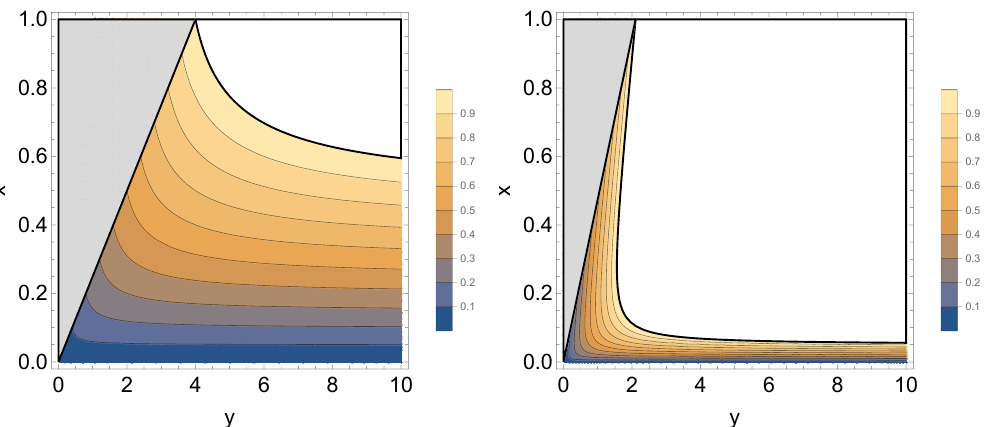
Figure 6: Density plot of the distance z from r = 0 to P in terms of x (NEC obeyed) and y . The gray area represents a region where the z > x condition is not met while the white area the region where the z < 1 condition is not met. y > z everywhere in = 1 while the right for Q = this region. The left plot is for Q 1 1